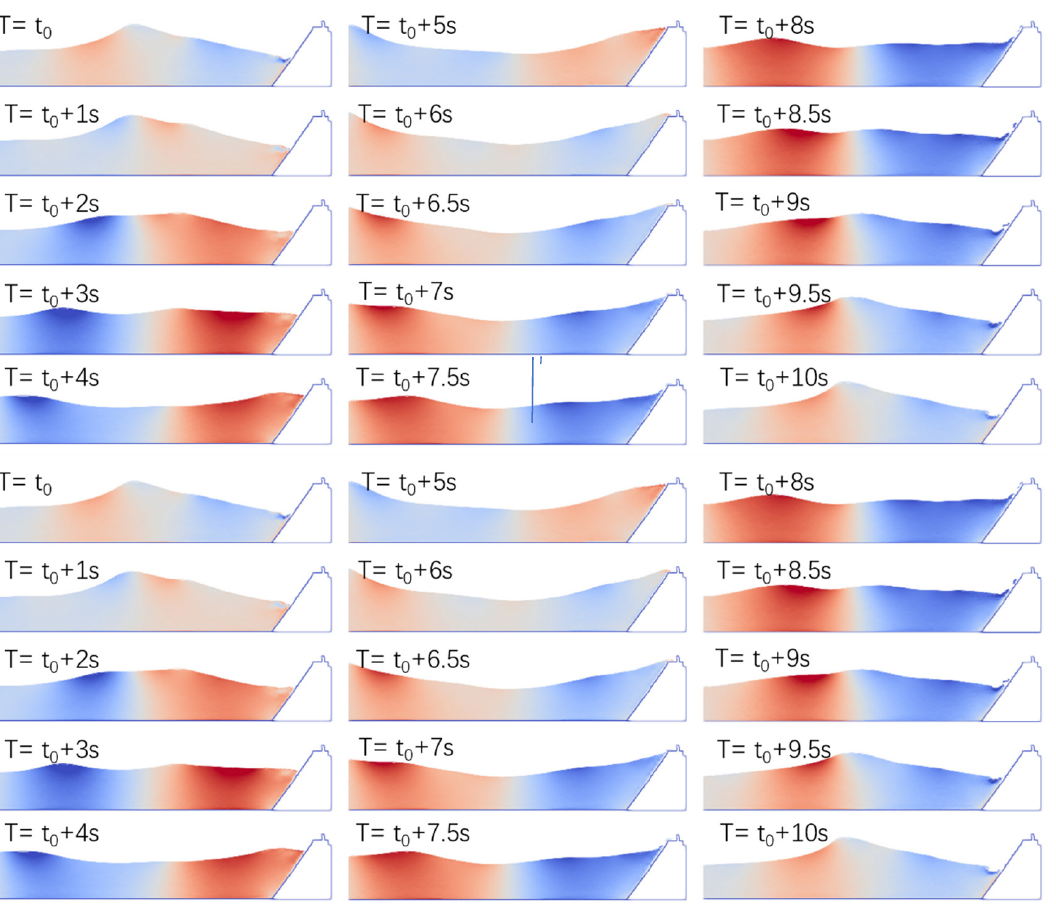
Figure 14. Different points in time during the wave run-up for Exp 2 of Typhoon Usagi at Dazuo Seawall .